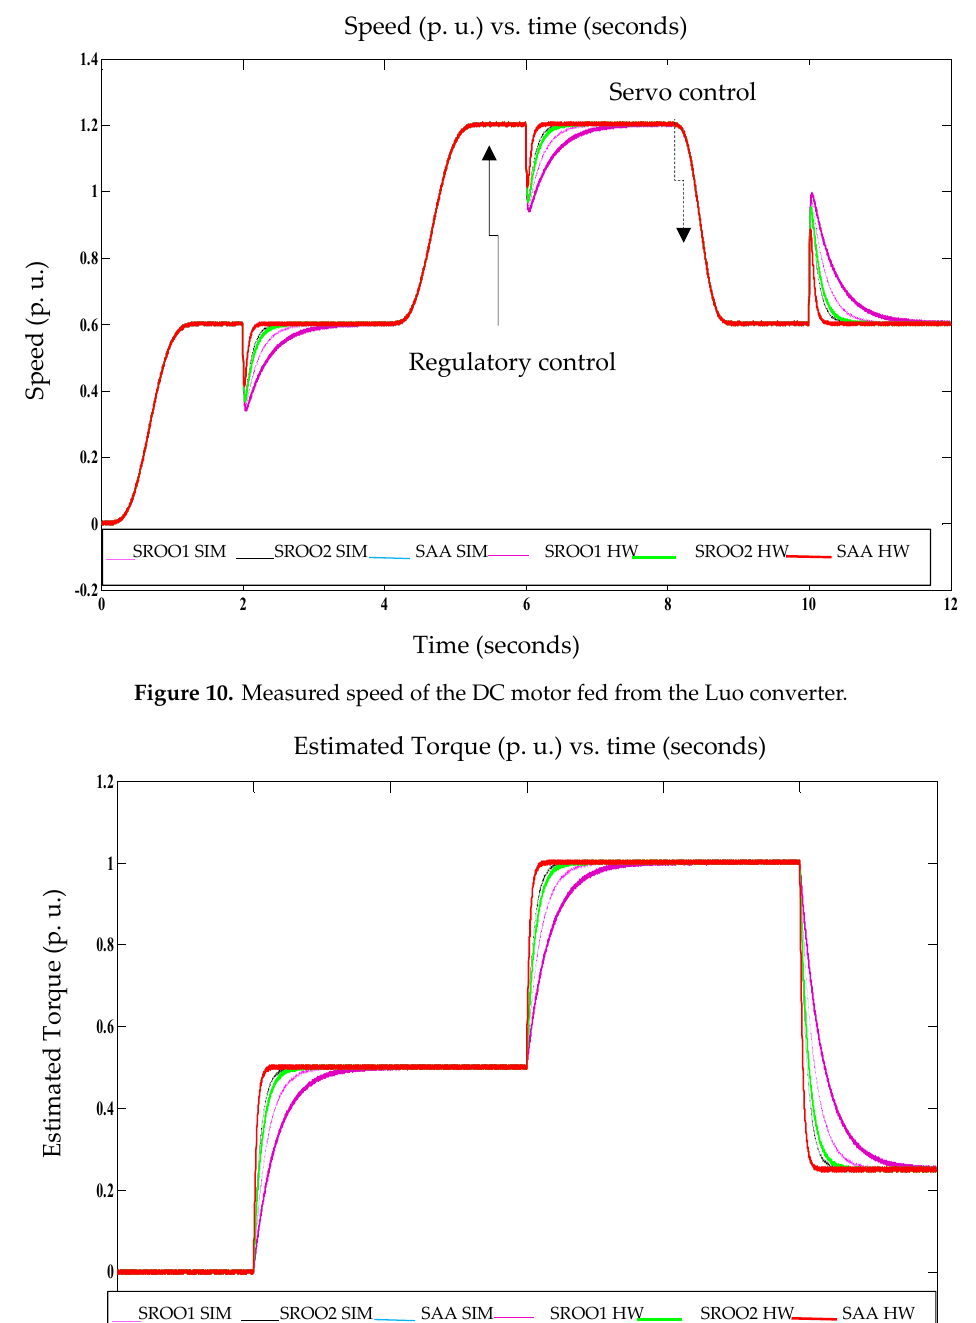
Figure 9. Armature voltage of the Luo converter-fed DC motor.